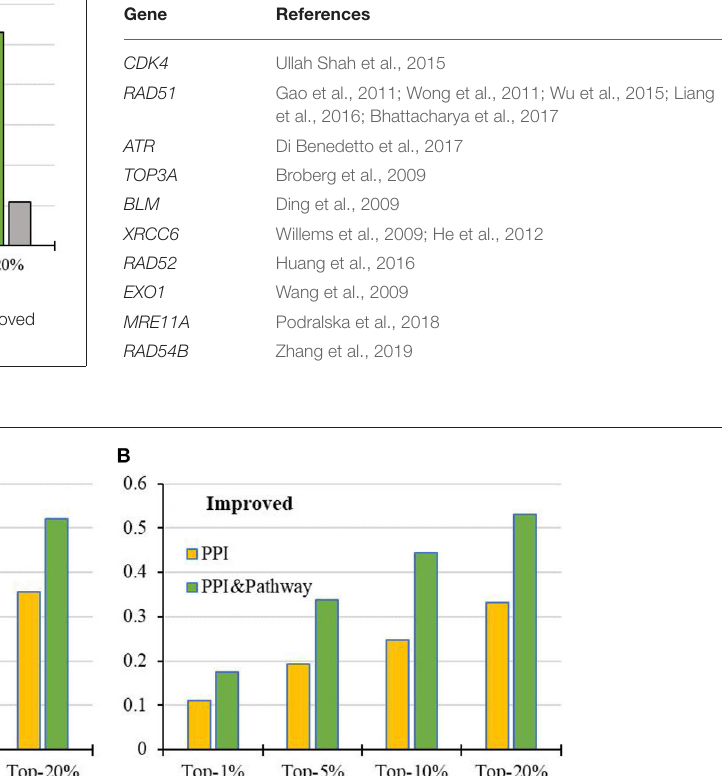
Frontiers in Genetics |